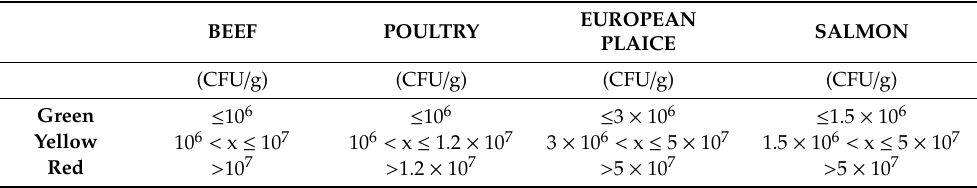
Table 6. Grouping of the analysed samples into three